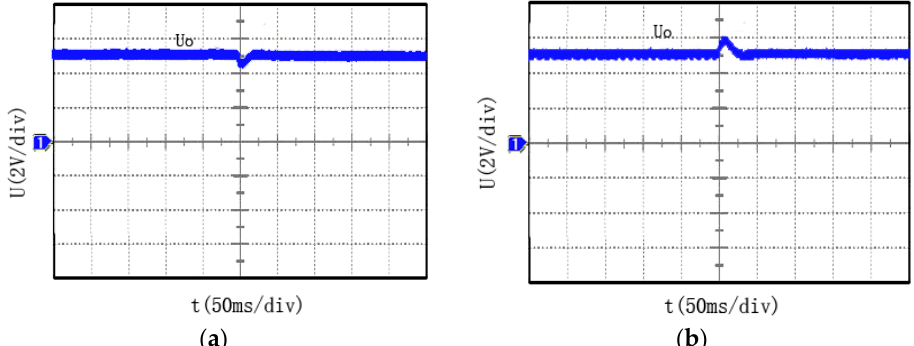
Figure 17. Output voltage waves of resistance mutation: ( a ) Load increases; ( b ) load decreases.